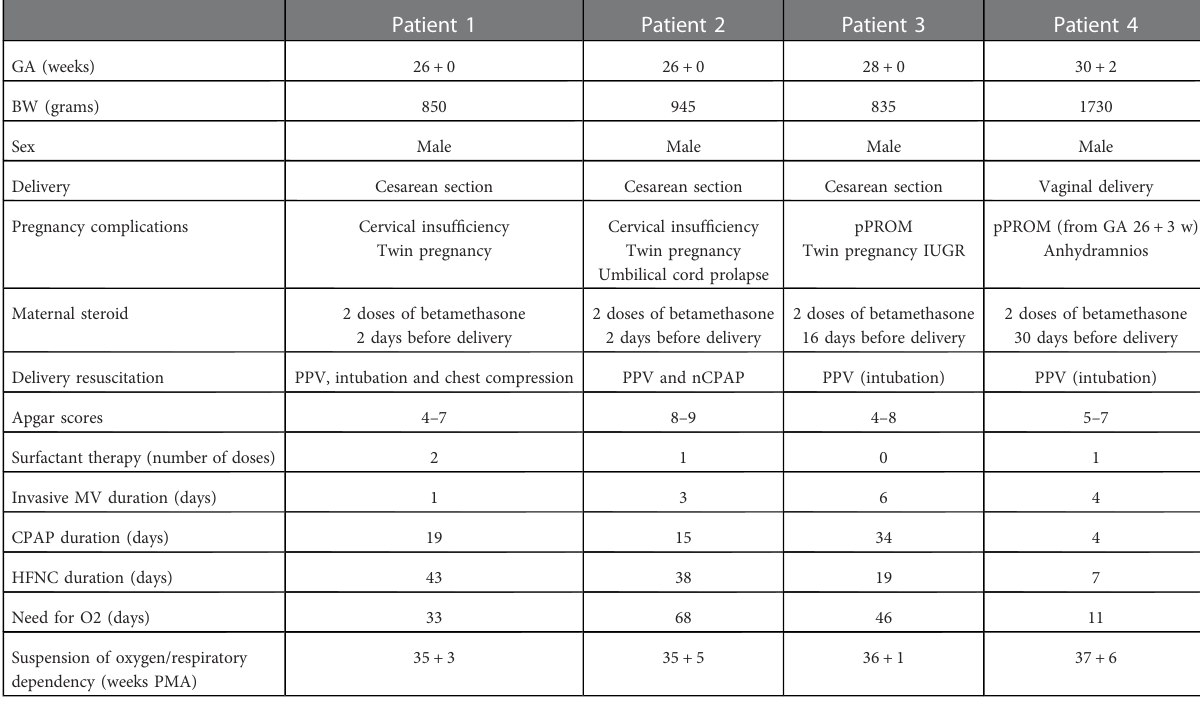
TABLE 1 Clinical characteristics of the